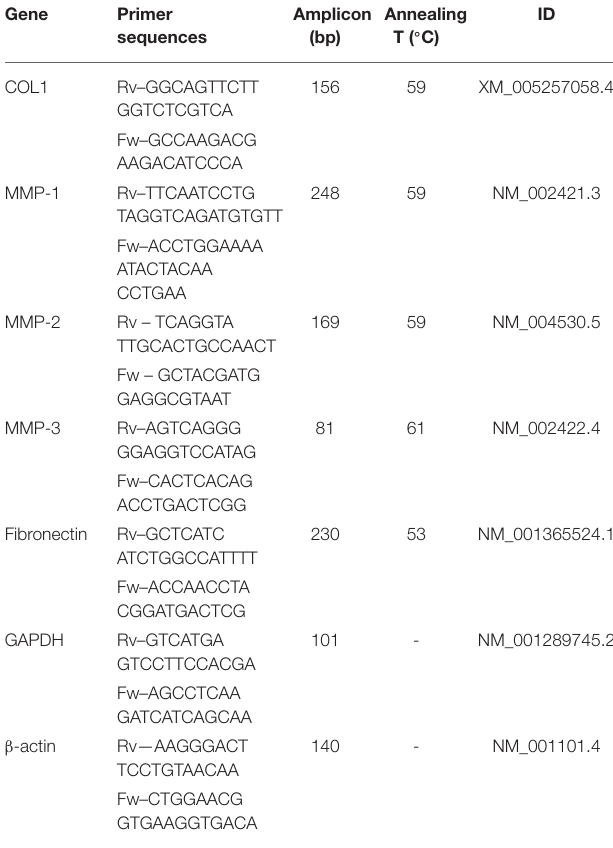
TABLE 1 | Human primers